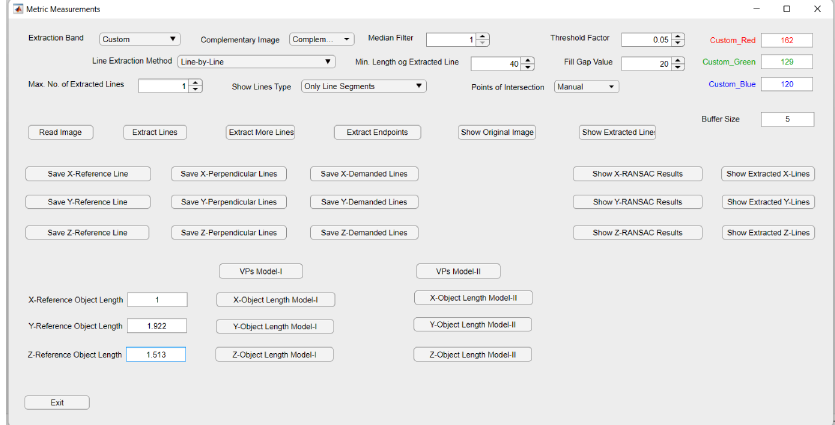
Figure 4. Application developed by MATLAB ® for metric